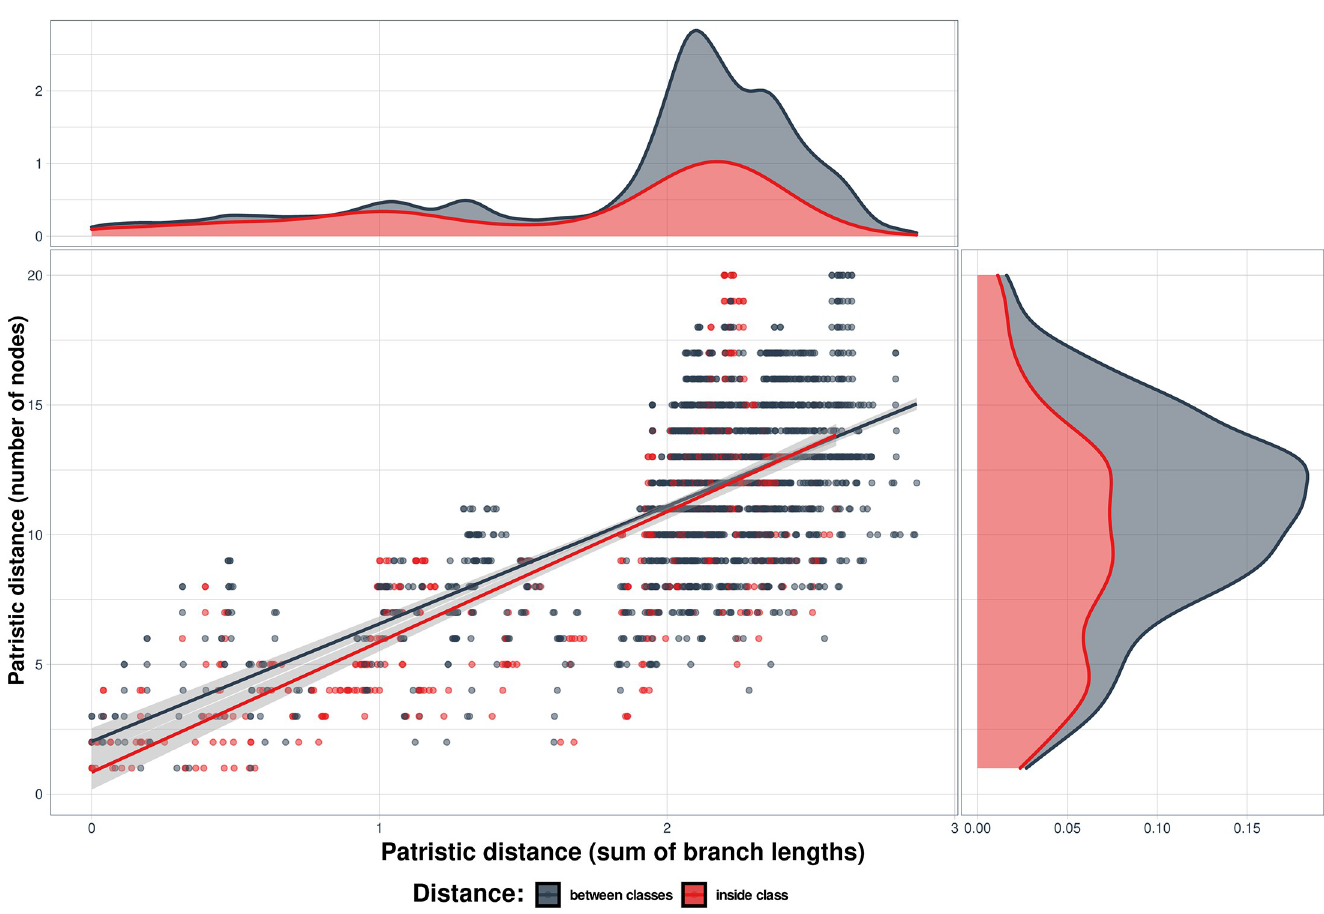
Fig 10. Comparison of patristic distances 1 vs. 2 between coronavirus genomes. The genome sequences were grouped according to disease they cause. Genome OTU pairs where the both genomes belong to the same group are highlighted in pink, the inter-group pairs—in gray. Shadows along the regression lines depict 95% confidence limits. The distribution of the values of elastic distances is presented above the main graph and patristic distances on its right side. Within group τ = 0.567, p = 2.2e-16; between groups τ = 0.410, p = 2.2e-16.